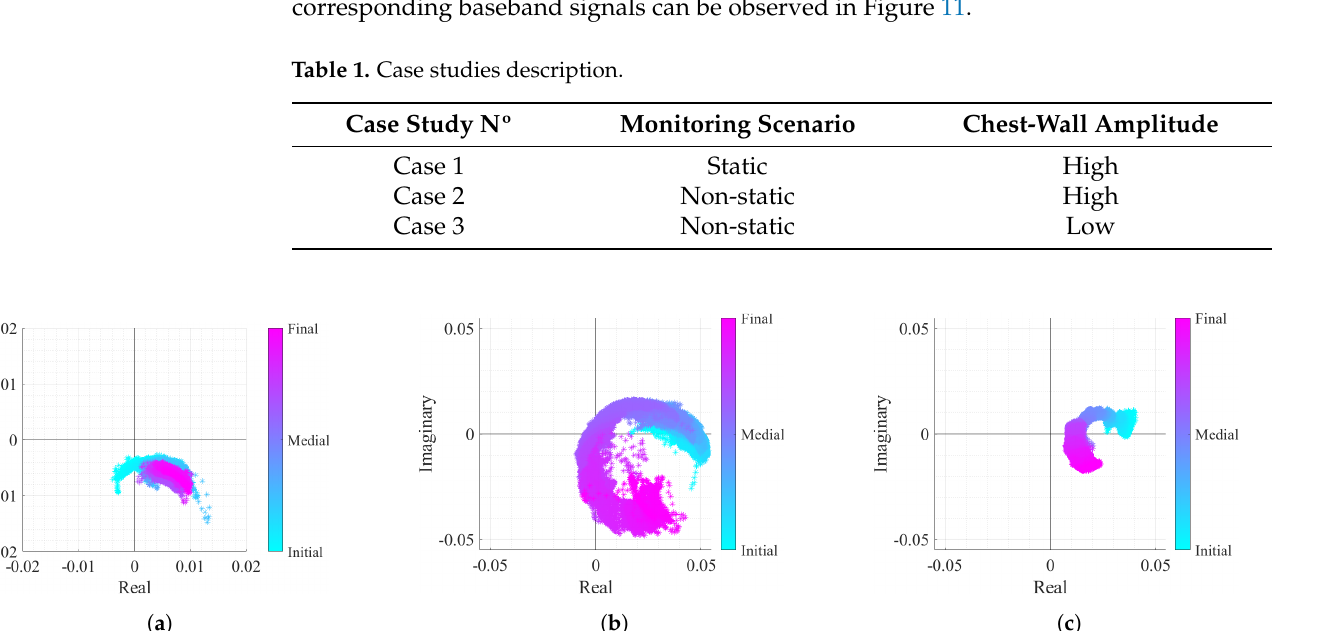
Figure 11. Real/Imaginary plots of the considered case study baseband signals: ( a ) Case 1, ( b ) Case 2, ( c ) Case